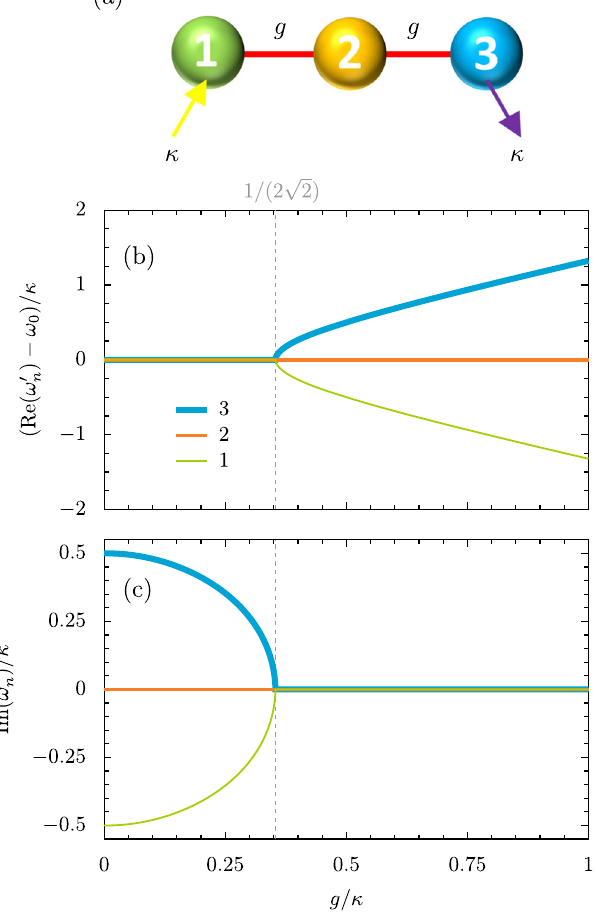
Fig. 1 The PT -symmetric trimer and its eigenfrequencies. a A cartoon of the three-site chain (colored balls), where each oscillator has the resonance frequency ω 0 . The left oscillator (green sphere) is subject to gain κ (yellow arrow), while the right oscillator (cyan sphere) suffers an equivalent loss κ (purple arrow), such that the arrangement ful fi lls PT symmetry. The coupling strength is g . b The real parts of the eigenfrequencies ω 0 function of g [Eq. (11)]. c The imaginary parts. Dashed lines: exceptional points at the transition between the broken and unbroken PT -symmetric phases [Eq.